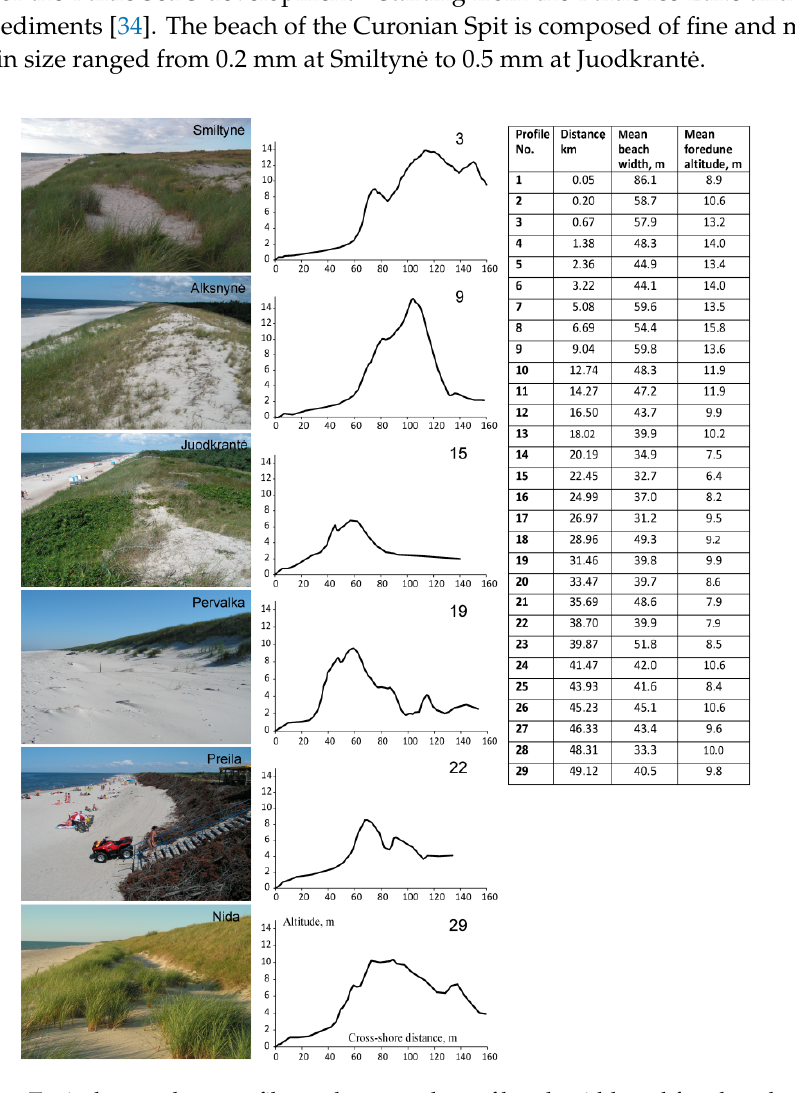
Figure 1. Location map. The black lines and numbers represent cross-shore profiles (Google Earth, earth.google.com/web/.).